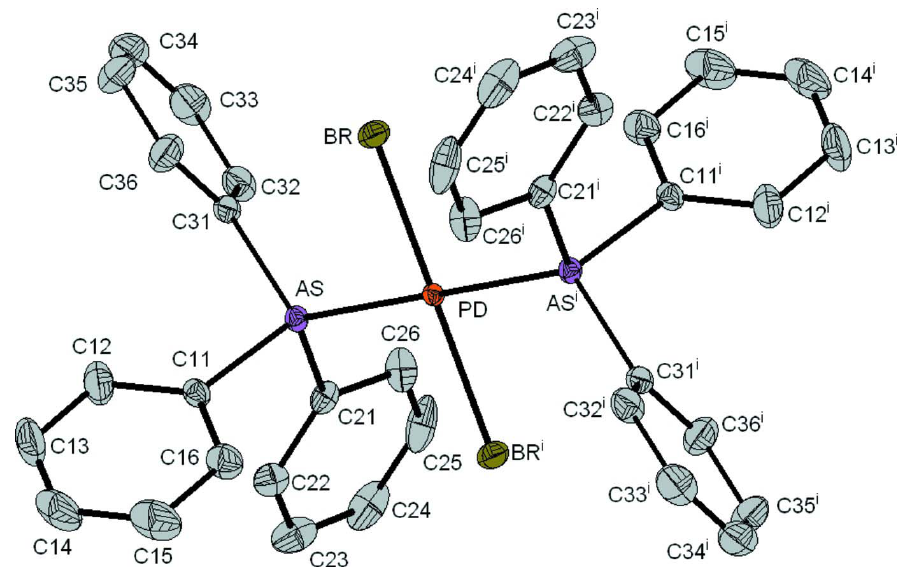
Figure 1 Molecular structure of (I) showing the atomic numbering and 50% probability displacement ellipsoids [symmetry code: (i) 1-x, 1-y, 1-z]. Hydrogen atoms have been omitted for